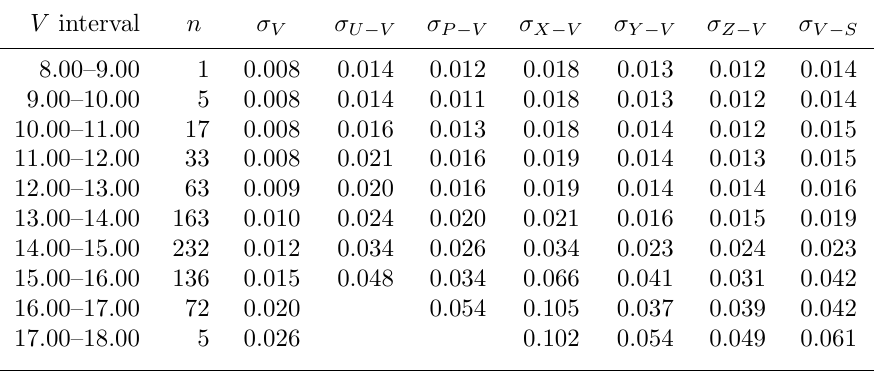
Internal accuracy of the photometric catalog. The table gives the mean r.m.s. errors in ten magnitude intervals.